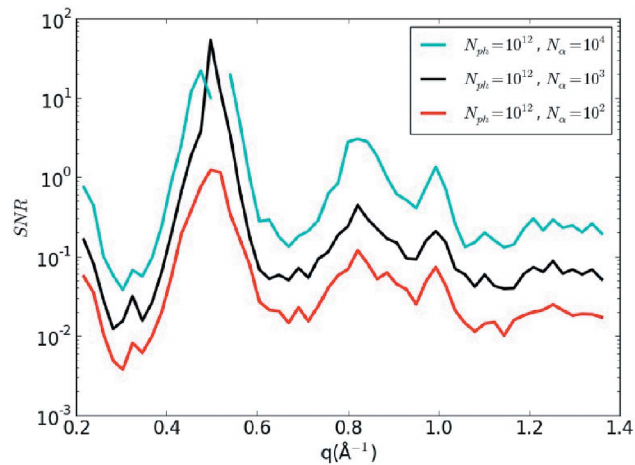
Figure 5 The numerically calculated SNR as function of the number of patterns. The signal is the standard deviation of the noise-free calculation and the noise level is calculated from the difference between the variance of each noisy simulation and that of the noise-free simulation. The increase of the SNR is proportional to N (cid:3) 1/2 , as predicted by the theory in Appendix